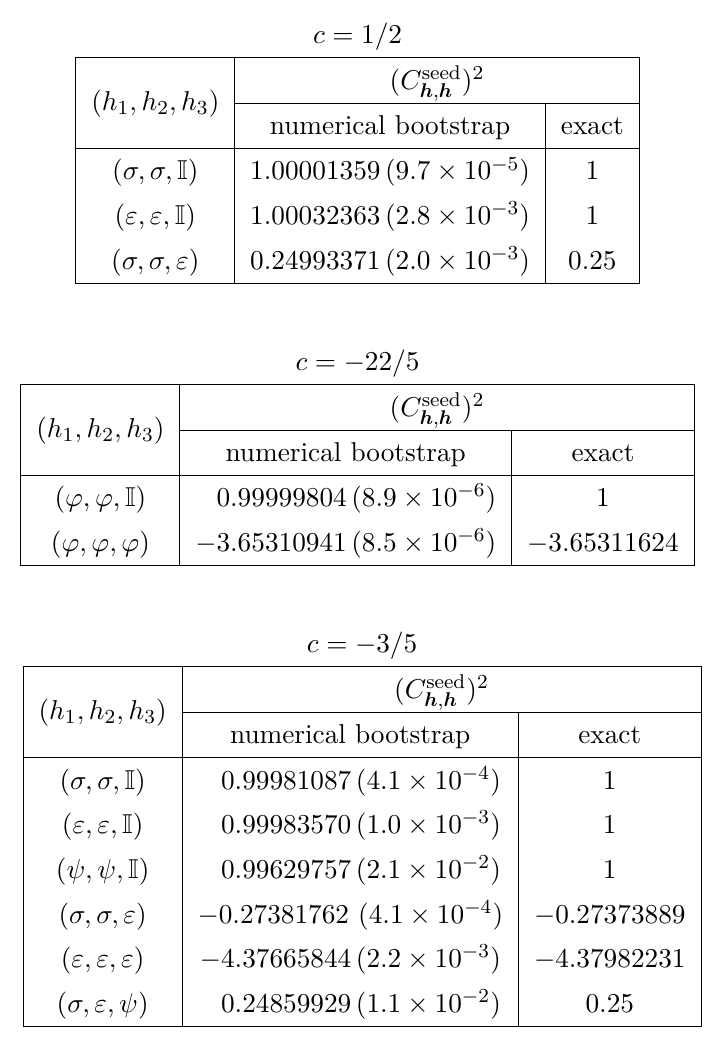
Table 2 . Results of the numerical bootstrap for the Ising (top), Lee-Yang (center), and the Gaffnian (bottom) CFTs on a genus two -symmetric Riemann surface ( N = 3 ). For each minimal model, Z 3 the second column collects the mean value determined for each structure constant after performing the bootstrap with 100 different sets of random points { z , fixing κ = 0 . 22 . The sphere conformal j } block expansion and the elliptic recursion were truncated at level L, L 0 = 6 . In the brackets we write the coefficient of variation. The third column contains the exact value of ( C seed ) 2 , calculated in [70] h , h for the minimal